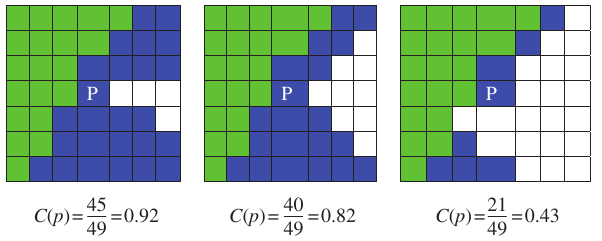
Figure 2. Confidence of Pixel p with a 7 × 7 Patch. White Indicates the Pixels of the Target Region. Pixels on Sharp Corners have High Confidence and hence are Filled on Priority, which Leads to a Simultaneous Neighboring Structure and Texture Propagation in the